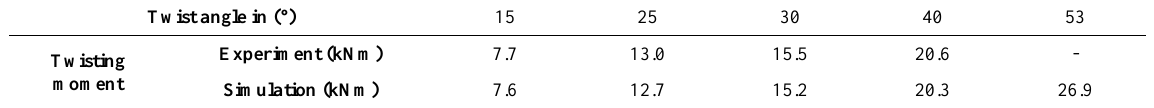
Table 6. Comparison of experimental and simulation results